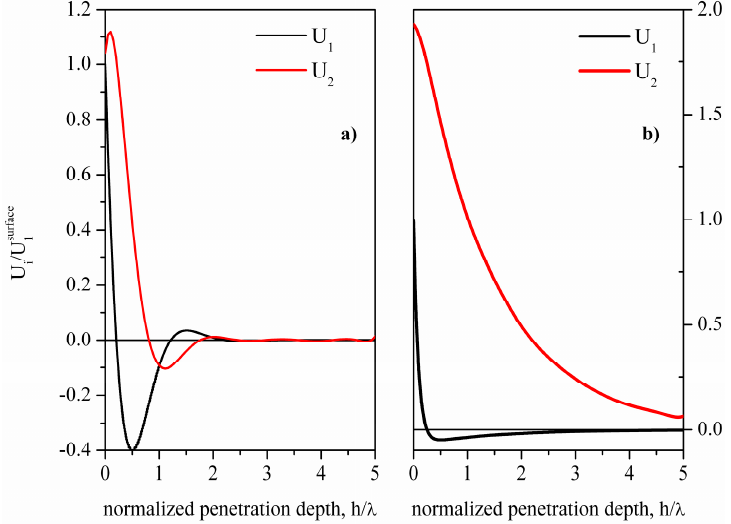
Figure 10. Variation of the normalized shear and longitudinal displacement components with depth of the Rayleigh-like wave propagating along <001>(110)SiC ( a ) and of the simple Rayleigh wave propagating along <110>(110)SiC ( b ).